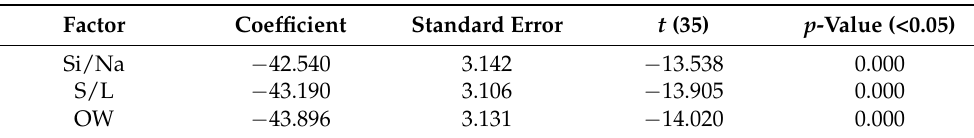
Table 5. Multiple regression analysis for compressive strength and dimensionless ratio of the SCSGPs (r 2 =